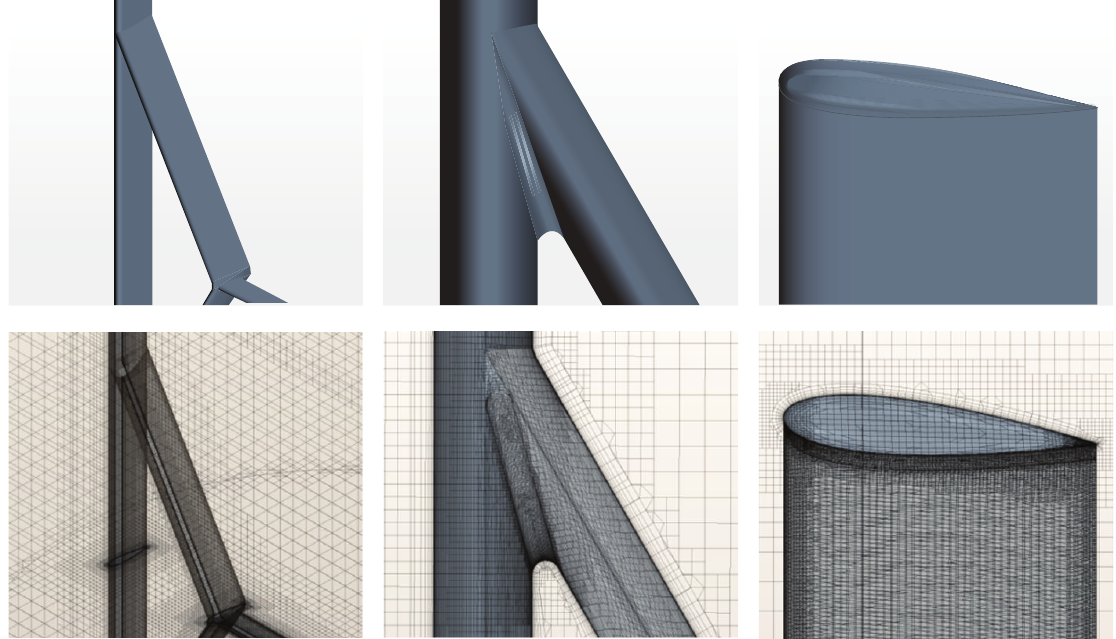
Figure 6: Turbine parts close up both of the CAD model and the final mesh; the latter visualized also with the mesh of the open space surrounding the